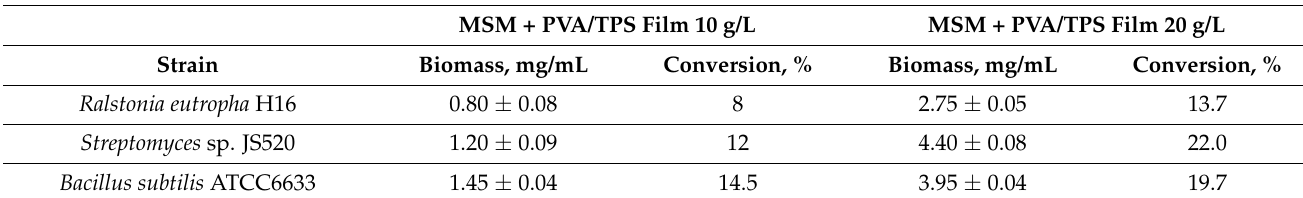
Table 3. Biomass yield (mg dry mass/mL of culture) and conversion rate from bacterial cultures grown in MSM medium containing 10 and 20 g/L of PVA/TPS